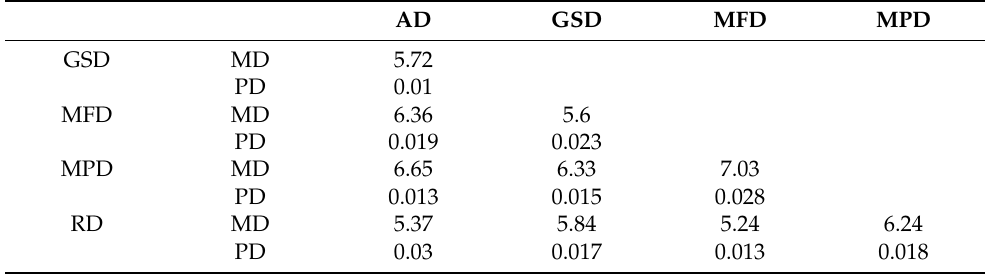
Table 5. Mahalanobis distances (MD) and Procrustes distances (PD) among the breed categories (half- breed Andalusian donkeys, AD; half-breed Grigio Siciliano donkeys, GSD; half-breed Martina Franca